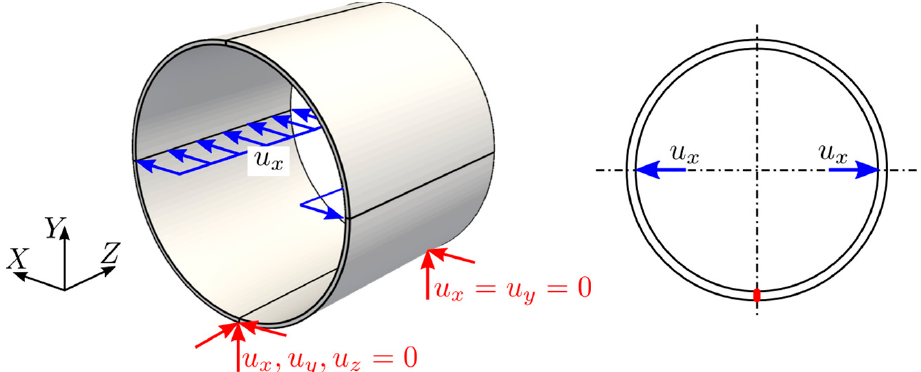
Figure 11. Idealized Boundary conditions.